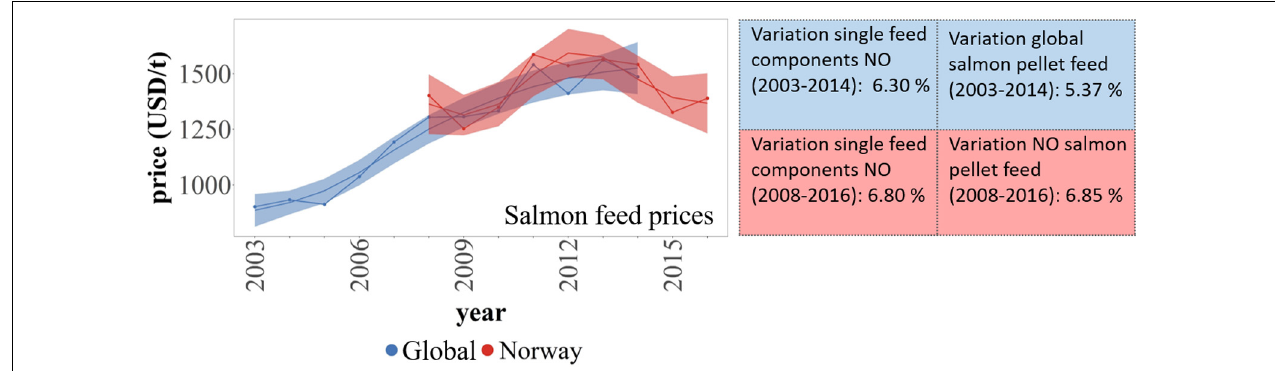
FIGURE 7 | Historical fish feed price trend covering global feed prices from the company EWOS R (cid:13) as a feed supplier in the international aquaculture industry and Norwegian (NO) feed prices for the respective available historical data coverage (line with dots) in USD/unit with the generalized additive model (GAM) fit (solid line) and the 95% confidence interval corresponding to the predicted standard error of the model fit (shade). Maximum price variability of the fit is given within table on the right and compared to that of single feed components deriving from Figures 5A,B , each for the same time period. Data sources: Salmon pellet feed prices in Norway: Norwegian Directorate of Fisheries (2020), Global salmon pellet feed prices from EWOS: (Aquaflashblog,